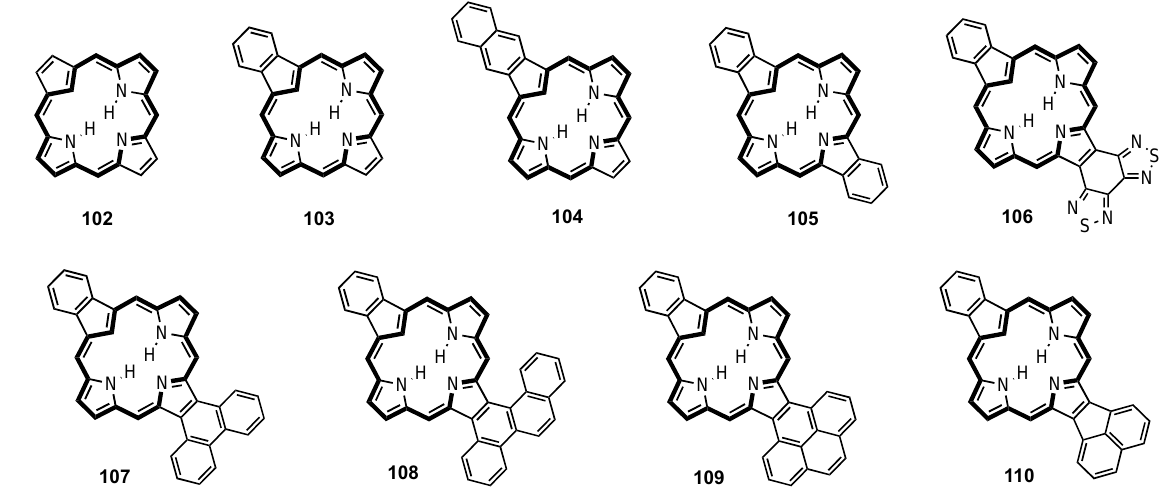
Figure 5. Selected Examples of True Carbaporphyrins.